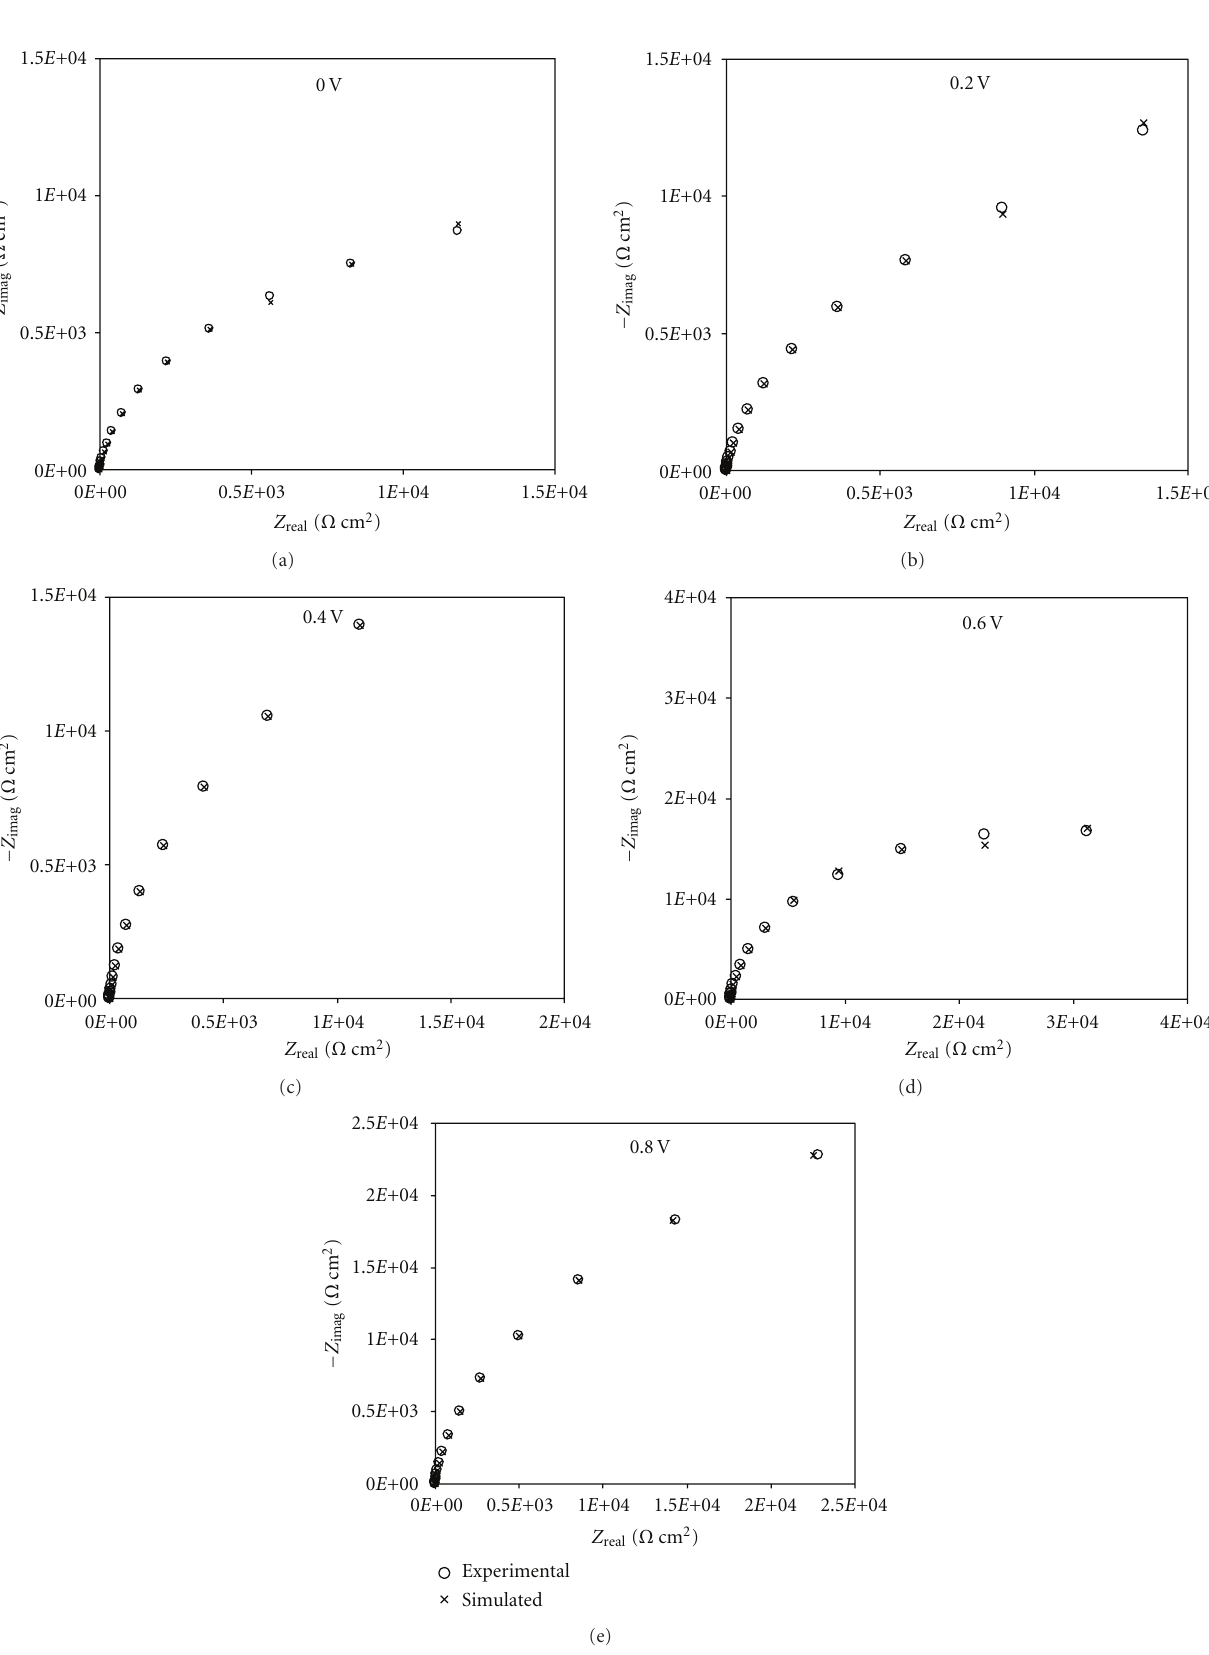
Figure 7: Nyquist plots for AISI 321 stainless steel in 0.5MH 2 SO 4 and as a function of potential showing a comparison between the experimental and simulated